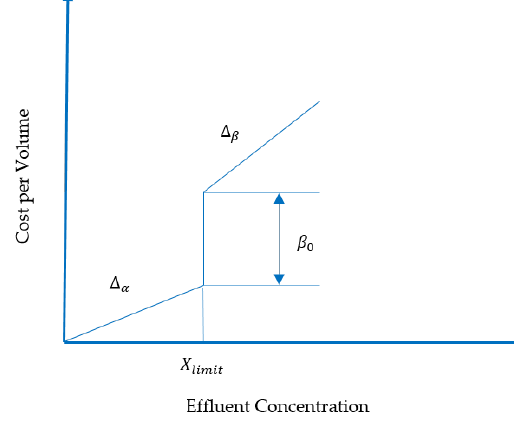
Figure 2. Cost function for effluent fines.